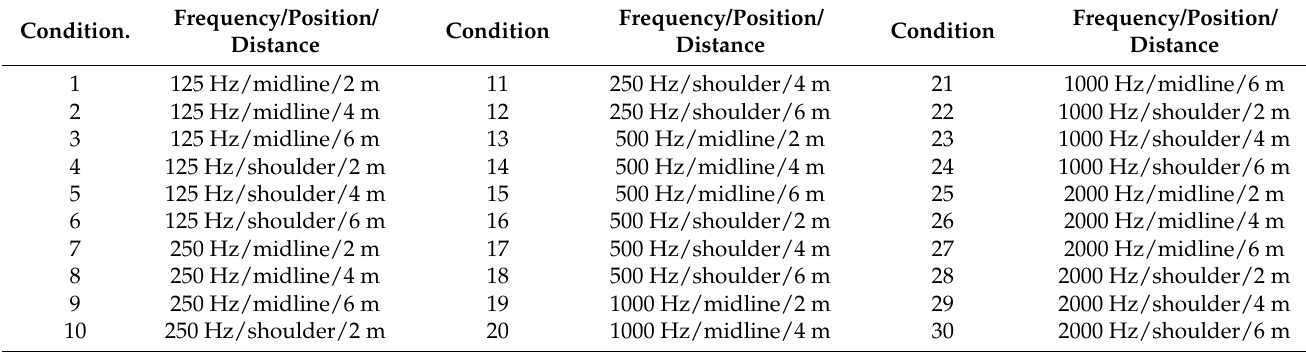
Table 2. Test condition of Case